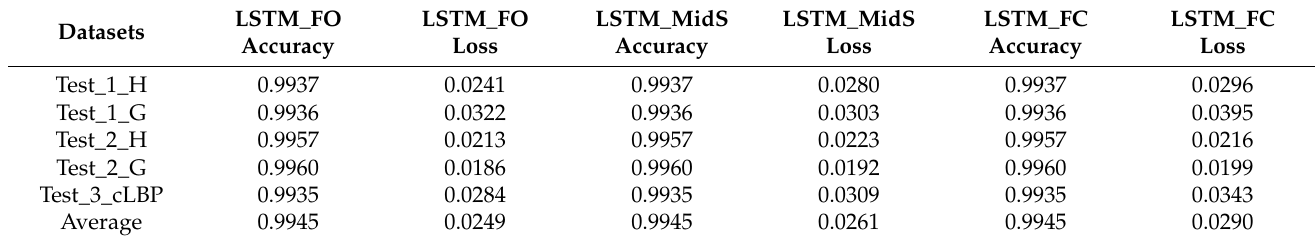
Table 3. Accuracy and loss on test